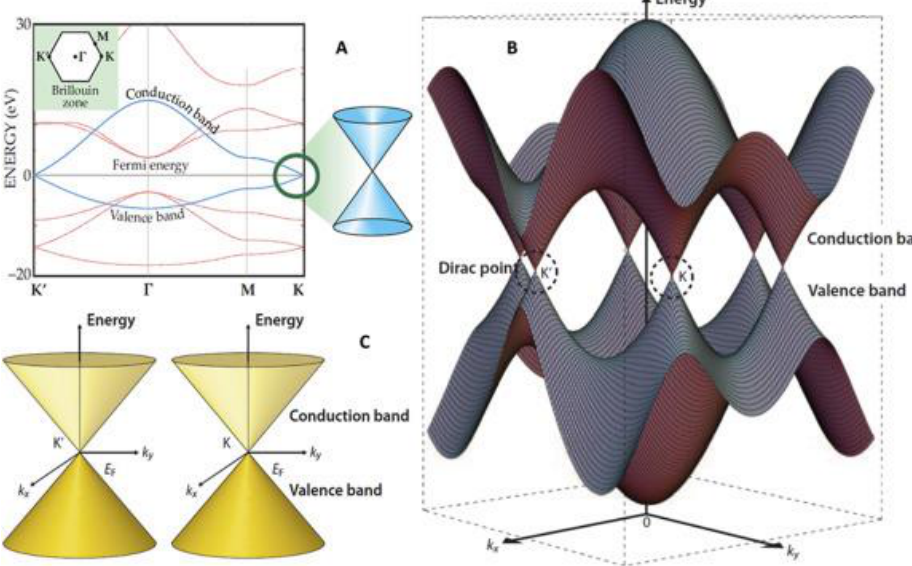
Figure 2. Band structure near the Fermi level of graphene. ( A ) 2D schematic diagram [39] , ( B ) 3D schematic diagram, and ( C ) Dirac cone of K and K’, which corresponds to the Fermi level of ( B ). Reproduced, adapted and reprinted with permission from Reference [40] .